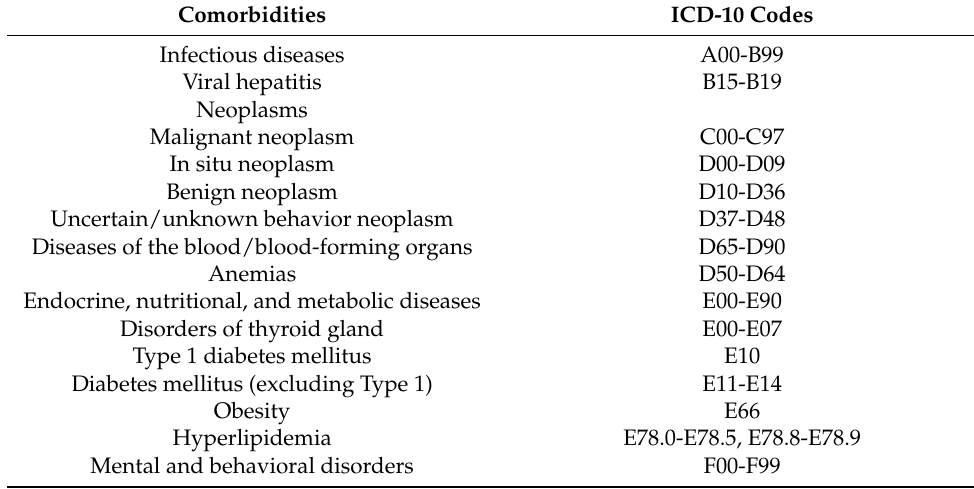
Table A1. Comorbidities according to